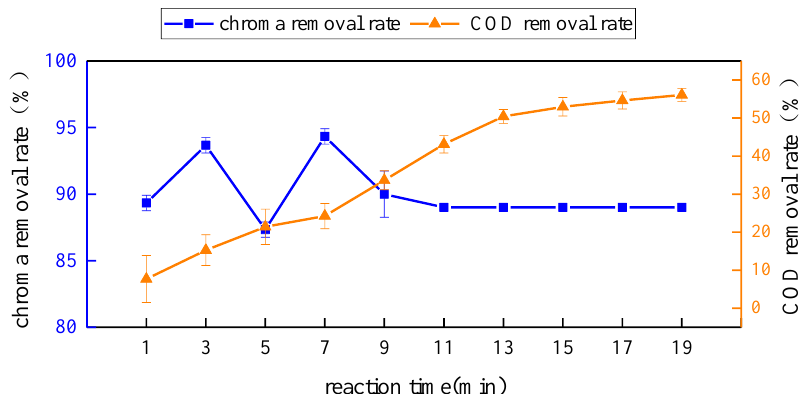
Figure 7. Chroma and COD removal rate curves under the combined action of ozone (25 g·m − 3 ) and manganese dioxide as catalysts (6 g·L −1 ).